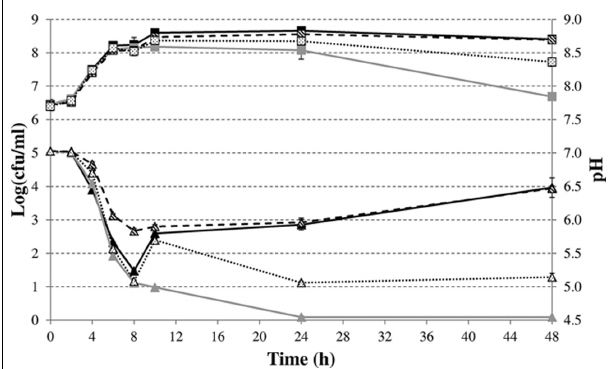
FIGURE 5 | Cell numbers (squares) and medium pH (triangles) during fermentative growth of S. plymuthica RVH1 wild-type (black solid lines), budAB::cat (gray solid lines), budAB::cat containing pTrc99A-P trc - budAB (dashed line), or (cid:2) hycE (dotted line) in LB medium with 5 g/l glucose at 30 ◦ C for 48 h. For the strain containing pTrc99A-P trc - budAB , 1 mM IPTG and 200 μ g/ml carbenicillin (Cb) were added to the medium. Error bars represent